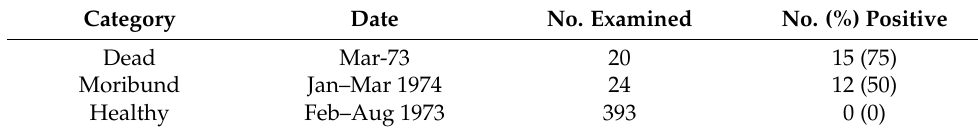
Table 4. Frequency of virus isolations from dead, moribund, and healthy bats.